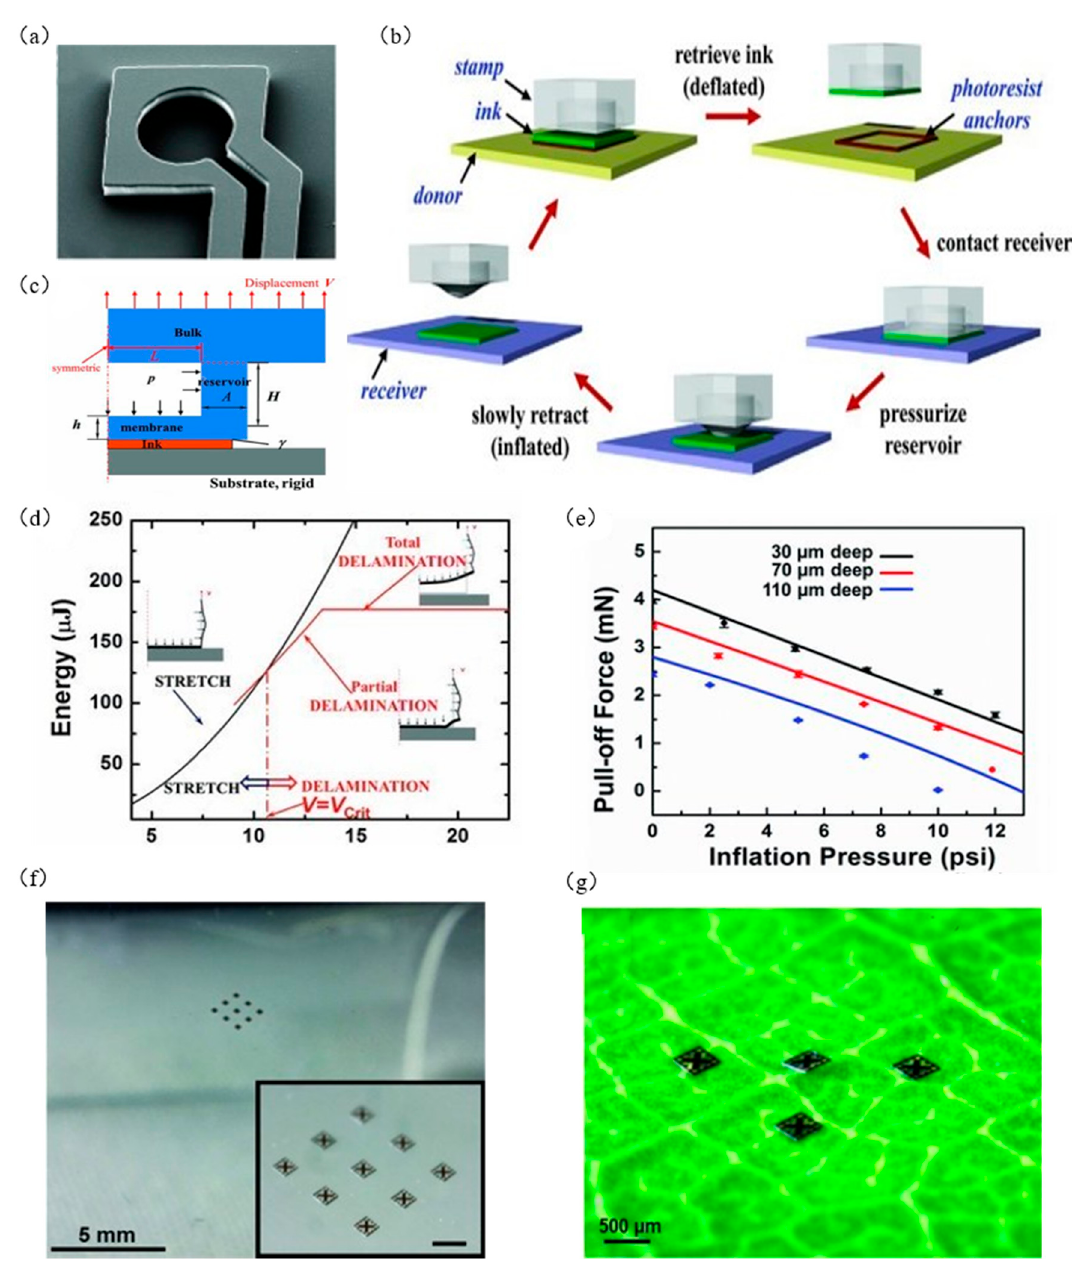
Figure 15. Transfer printing technology with inflatable seal. ( a ) Scanning electron microscope (SEM) of the inflatable seal (reproduced from [85]), ( b ) transfer printing diagram of seal inflation and expansion (reproduced from [85]), ( c ) mechanical model of inflatable seal (reproduced from [85]), ( d ) graph of the relationship between the displacement of the top of the seal and the energy (reproduced from [85]), ( e ) relationship between gas expansion pressure and tensile stress at different cavity depths (reproduced from [85]), ( f ) schematic diagram of 3 × 3 array silicon wafer transfer printing on PET target substrate (reproduced from [85]), and ( g ) schematic diagram of wafer transfer printing on blade (reproduced from [85]).